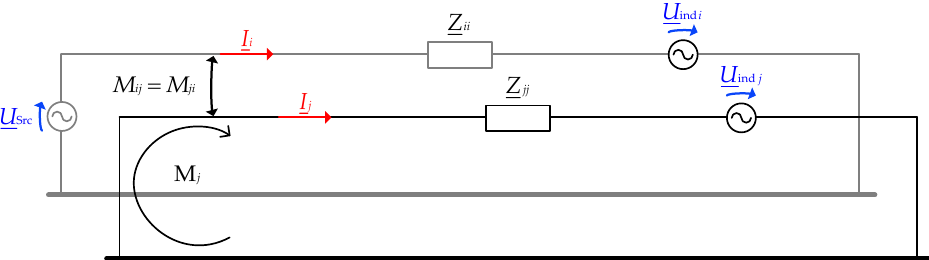
Figure 1. Inductively excited